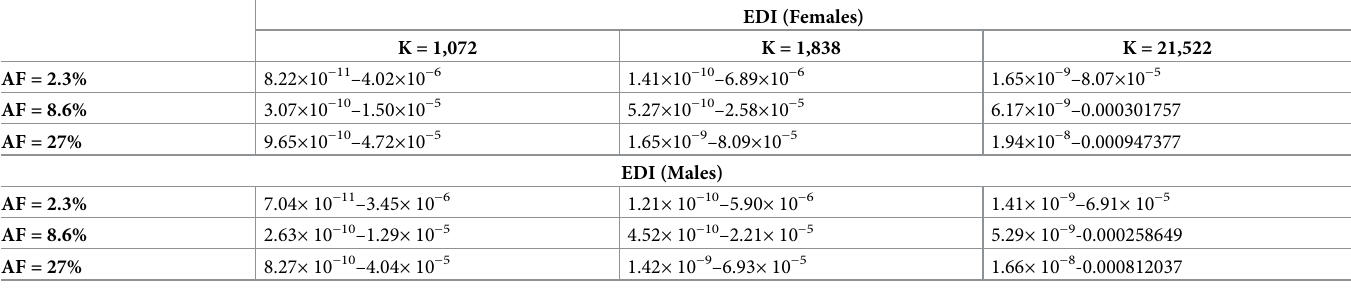
Table 4. EDI ( μ g/kg bw/day) range for general population (females and males) from “restaurant” thermal paper receipts under varying AF and k values.